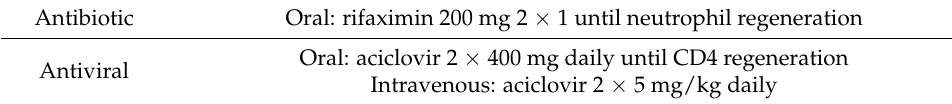
Table 1. Recommended prophylaxis at Heidelberg University